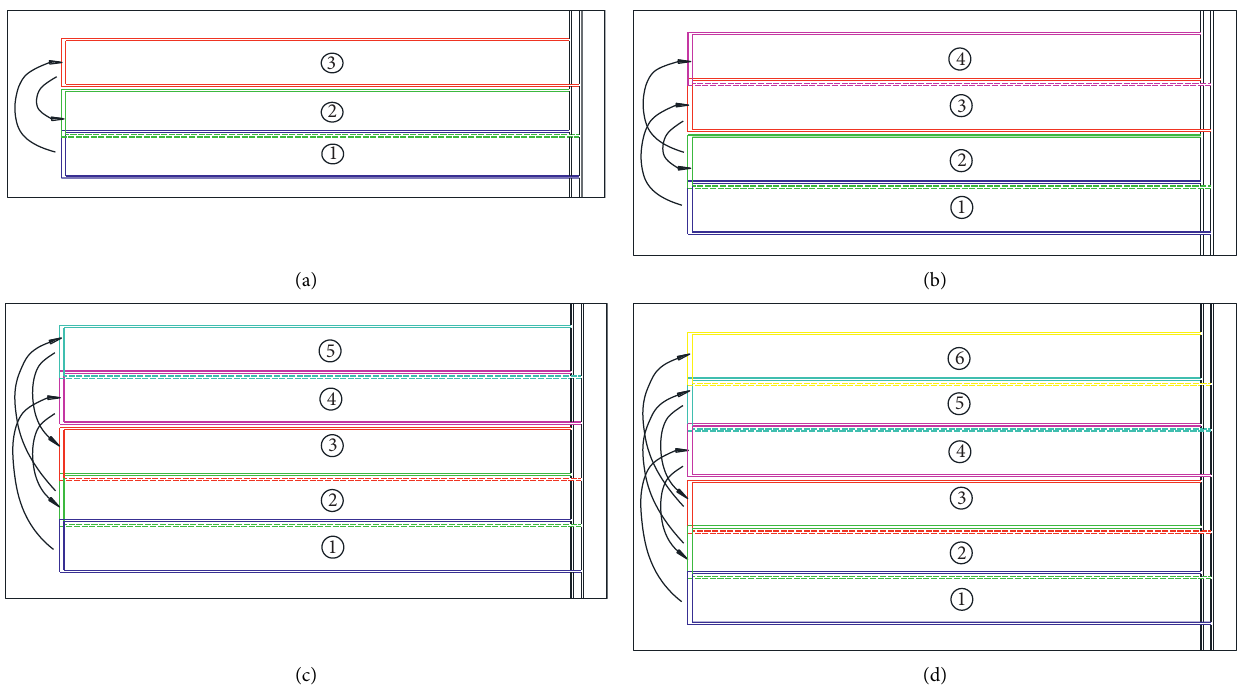
Figure 23: Mining sequence schemes for Tangshan Colliery: (a) three panels; (b) four panels; (c) five panels; (d) six